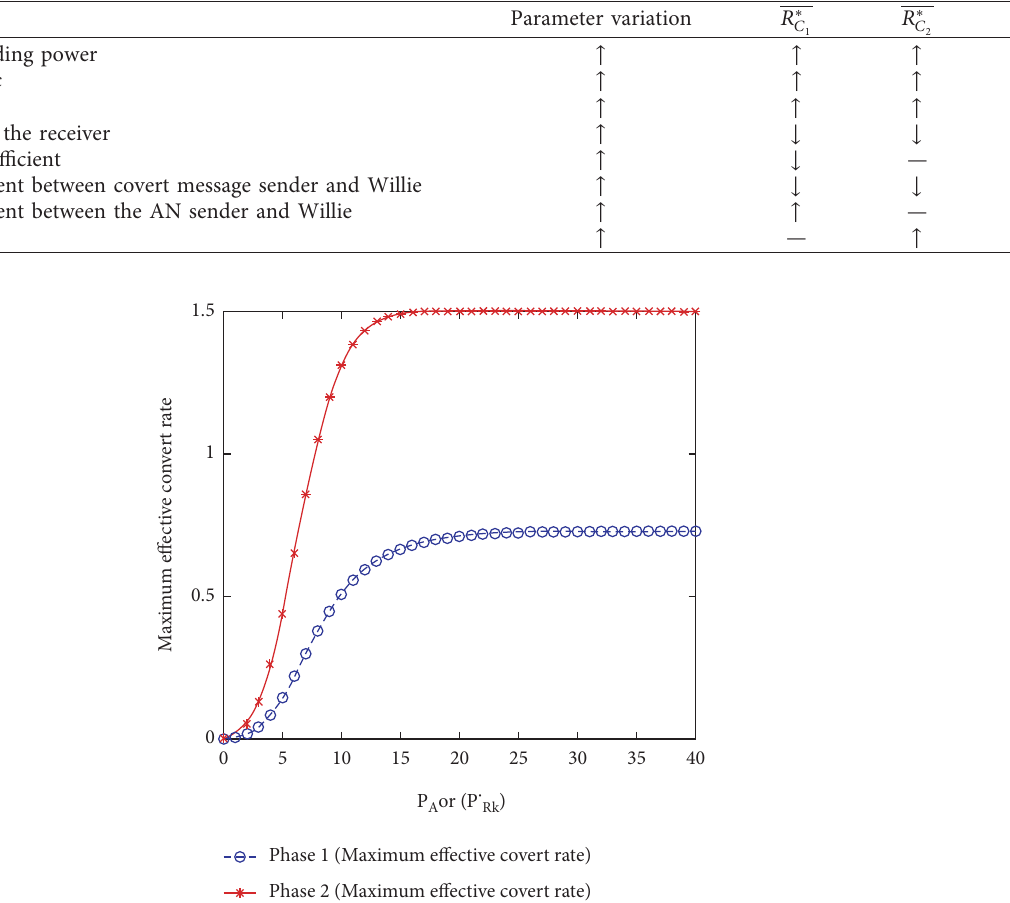
� 0 dB , σ 2 � 0 dB , P � 10 dB , R � 1 . 5, ϕ � 0 . 01, R k R B